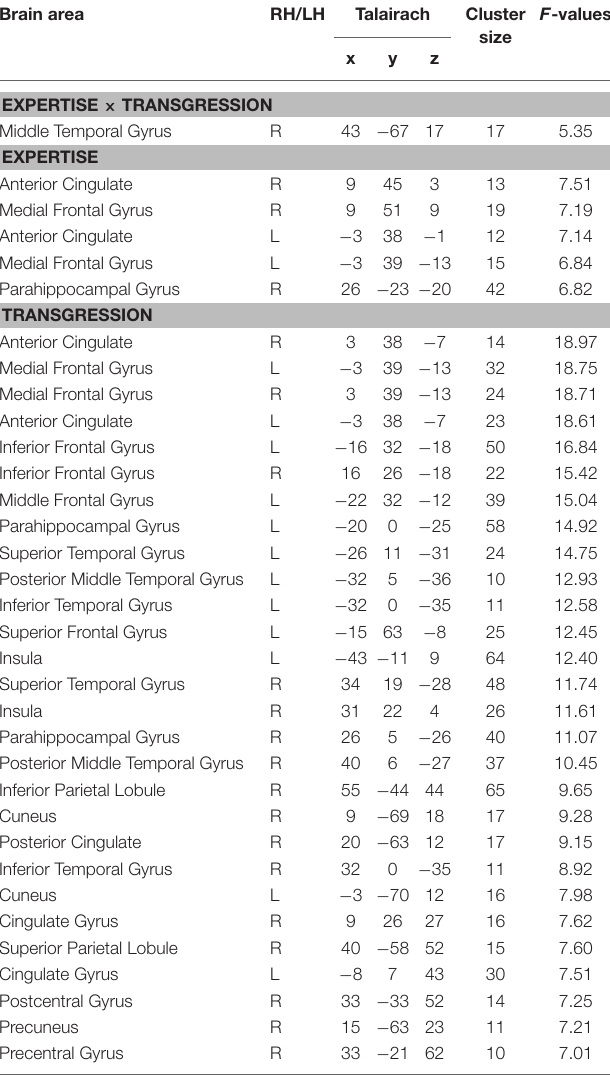
TABLE 3 | Results of the ANOVA EX (3, inter) × T (3, intra) on current density. Brain